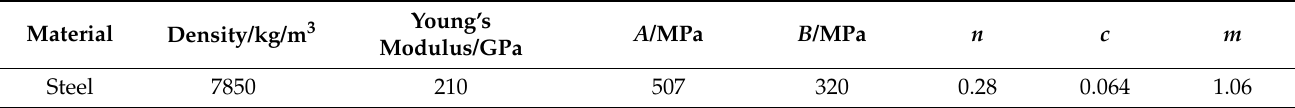
Table 1. Material parameters of the Johnson – Cook model [28].